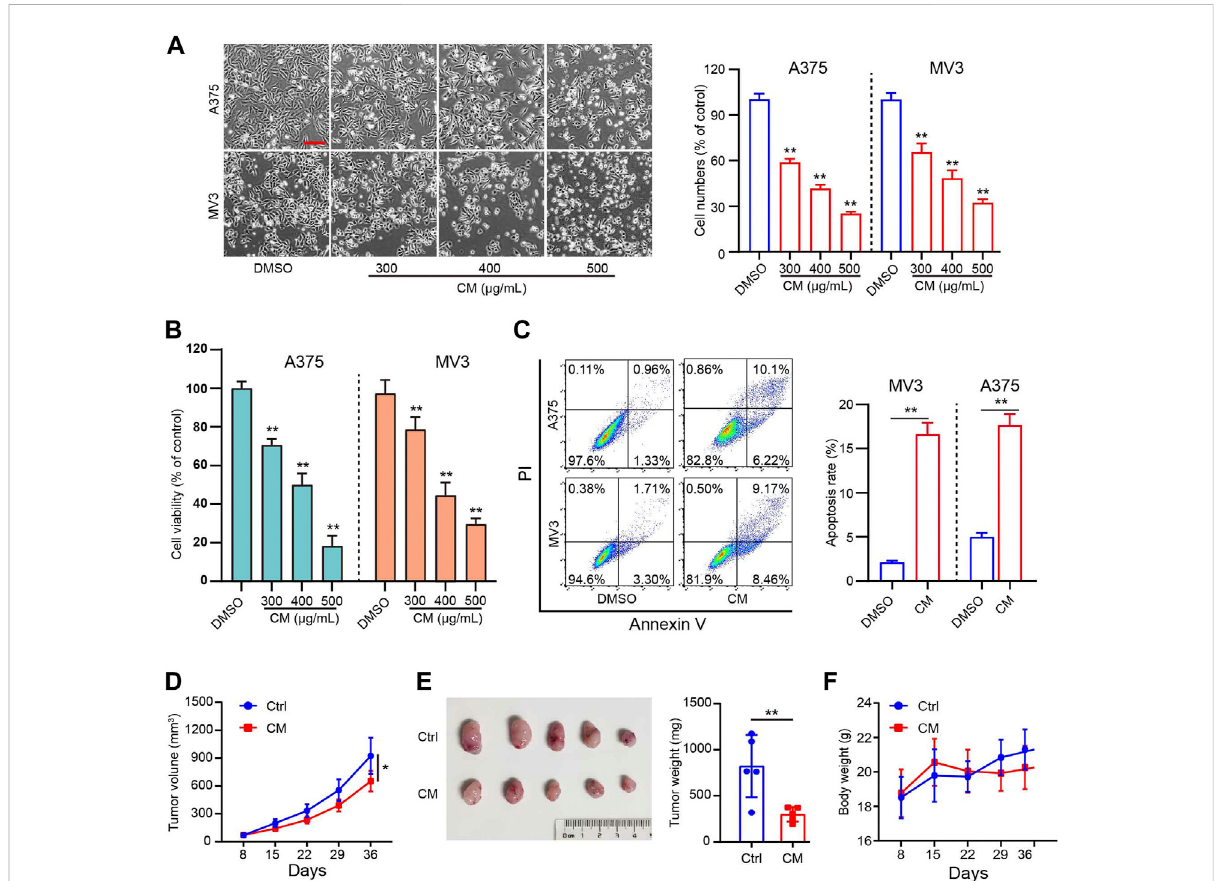
FIGURE 1 CMinhibitsmelanomagrowth invitro and invivo . (A) CellmorphologyofA375andMV3cellsafter48 hofincubationwithCMorDMSOandthe percentage of cells in each group is represented by the histograms, with the control group being 100% of the cells. Scale bar: 1 mm. (B) Cytotoxicity of CM to melanoma carcinoma cell lines A375 and MV3. Cells were incubated with CM for 48 h, and the viability was determined by CCK8 assay. (C) A375 and MV3 cells were treated with CM for 48 h, and the apoptotic cells were evaluated and quanti fi ed by Annexin V/PI staining and fl ow cytometry. (D) Tumor growth curves of A375 tumor-bearing nude mice treated with control ( n = 5) or CM ( n = 5). (E) The effect of CM on tumor weight after resection. (F) The effect of CM on mice body weight. The asterisks indicate statistically signi fi cant differences (* p < 0.05 and ** p < 0.01). Ctrl: control. CM: Cortex Mori